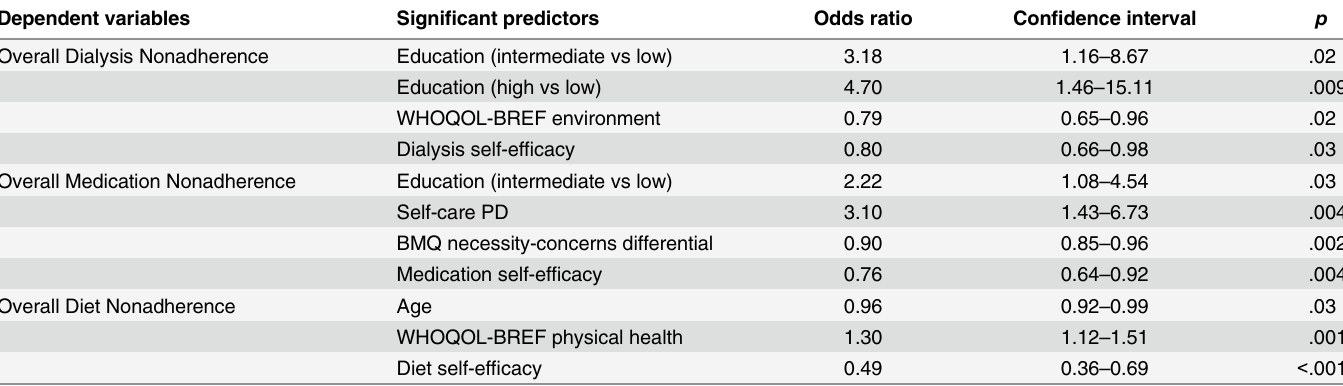
Table 4. Summary of Logistic Regression Analyses to predict